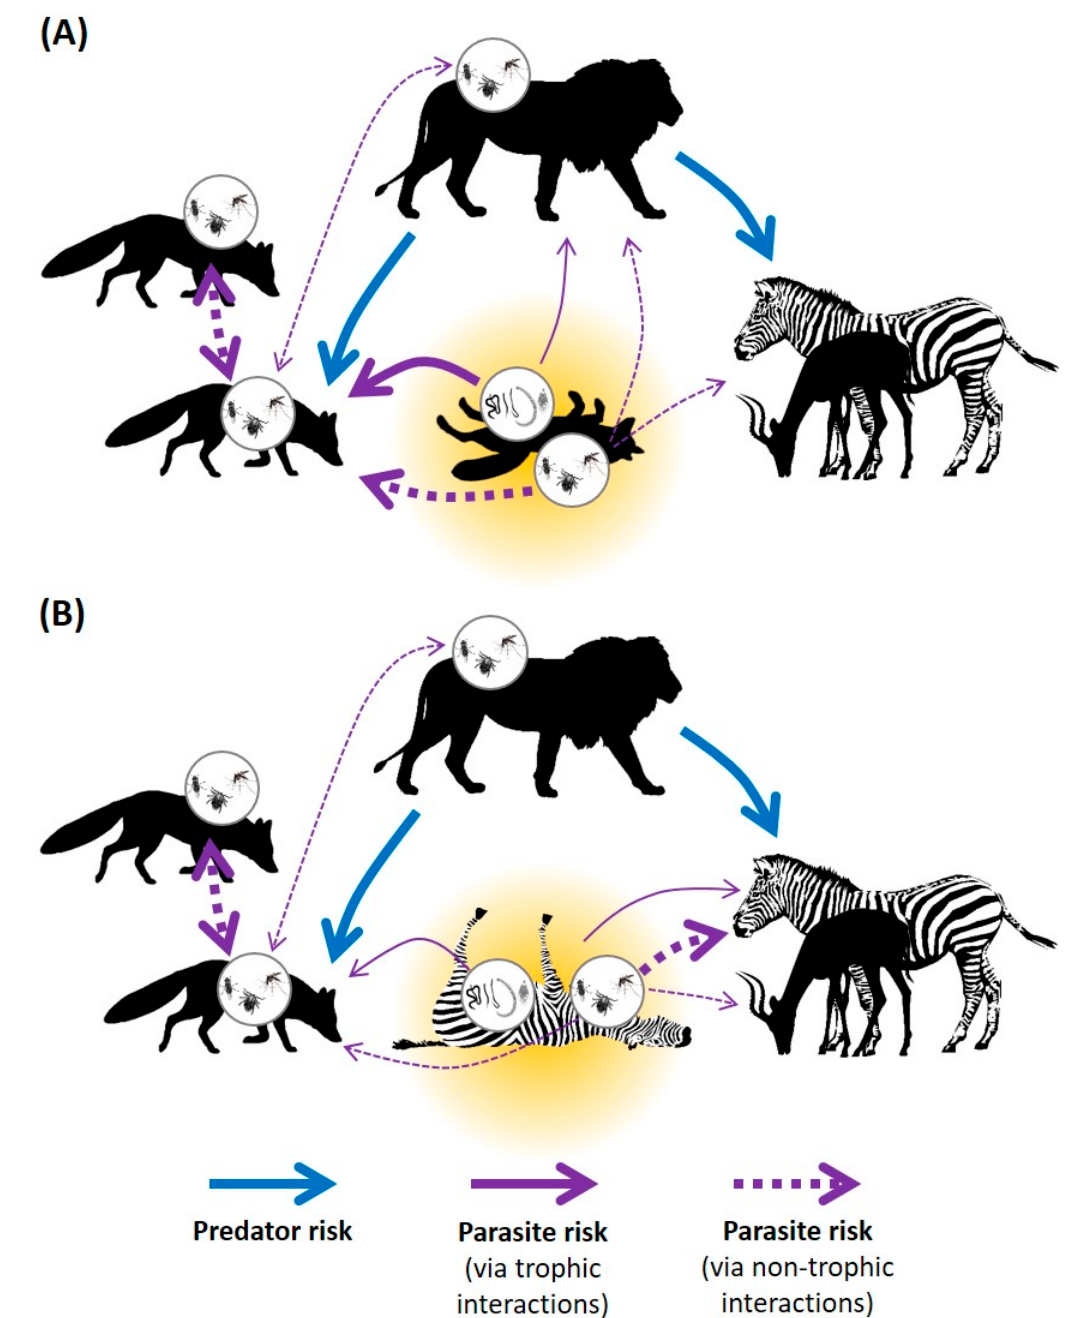
Figure 2. Animal carcasses may be both disgusting and scary. However, the parasite and predator risks vary widely according to the species identity of the carcass and its visitors. ( A ) Carnivores visiting carnivore carcasses may face both predation and infection risk. Parasites may be transmitted to carnivores by either the carcass or other carnivore visitors, with the probability of transmission being proportional to their phylogenetic relationship [29,30]. ( B ) Herbivore carcasses are relatively safe for carnivores in terms of direct parasite transmission (at least, regarding direct life cycle parasites), but these carnivores may still be subject of parasite and predation risk from other carnivores. Herbivores may be at predation and parasitism risk at both carnivore and herbivore carcass sites, with the latter representing comparatively higher risk of acquiring parasites. Interactions among carnivores are more frequent at large carcasses [31] and in the absence of vultures [32], which are highly efficient scavengers [33,34]. Arrow width is roughly proportional to the intensity of risk.